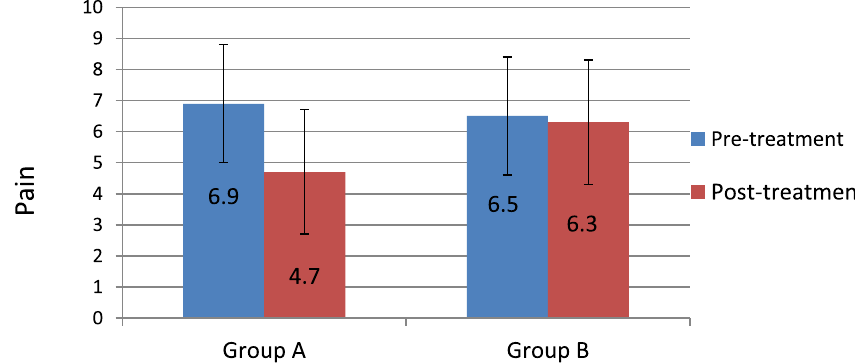
Fig. 7 Mean values of pain pre- and post-treatment within each